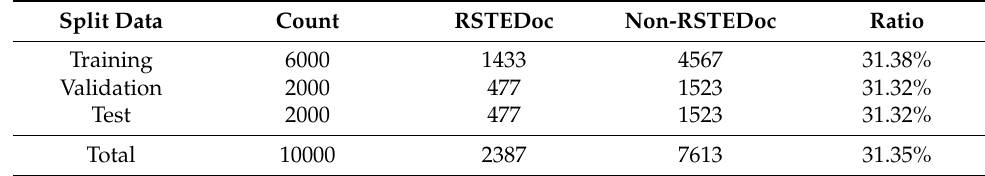
Table 2. Training data distribution ratio for model